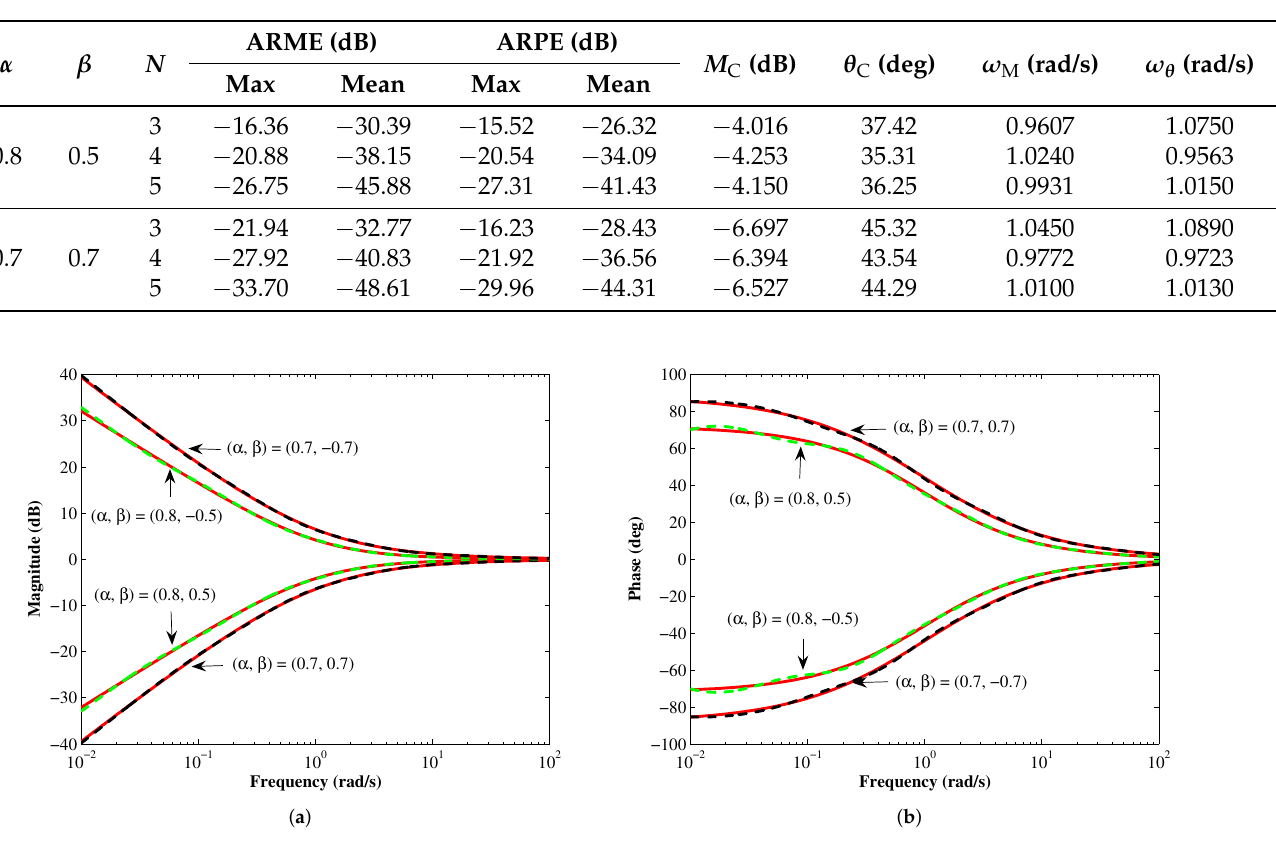
Table 5. Performance indices of the designed FHPFs for different values of N .